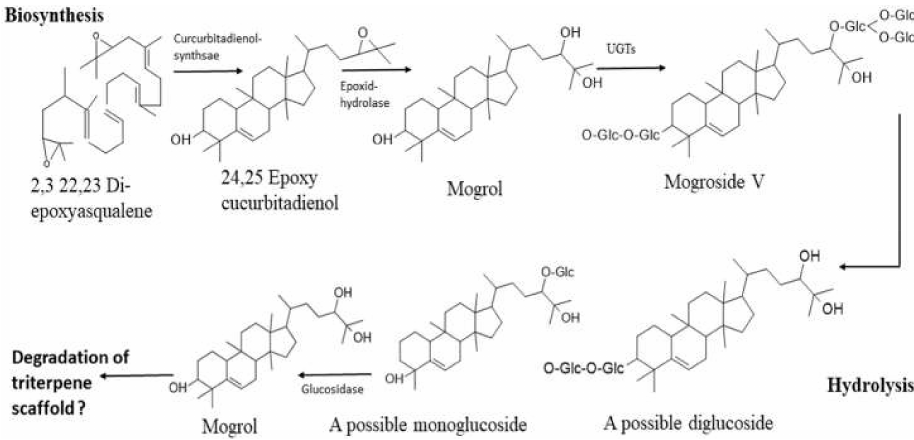
Figure 5. Biosynthesis of mogroside V in Siraitia grosvenorii and hydrolysis of consumed mogroside in the gut of humans